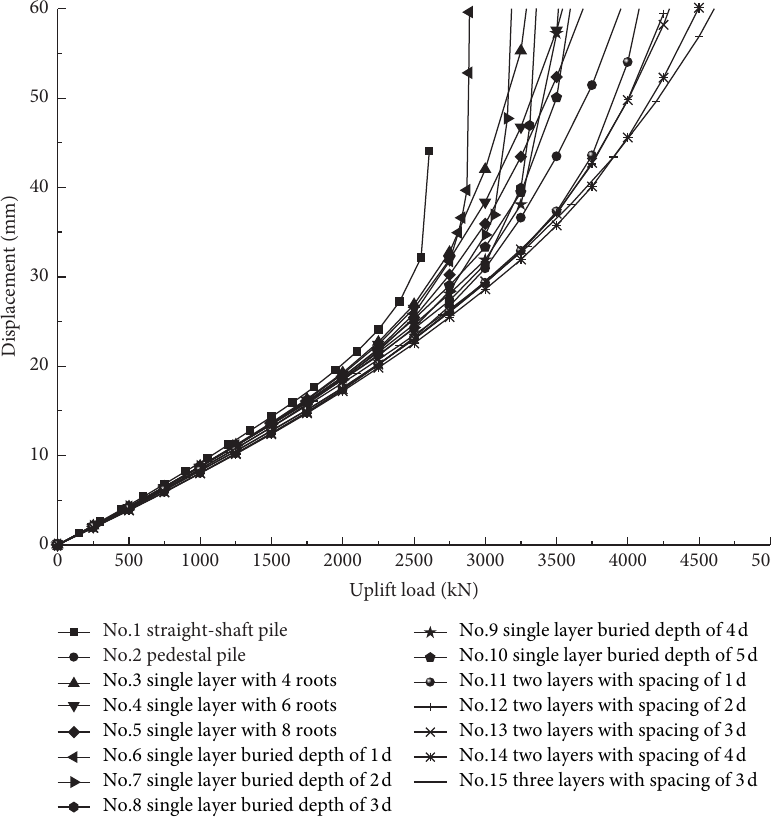
Figure 6: Uplift load displacement of pile No.